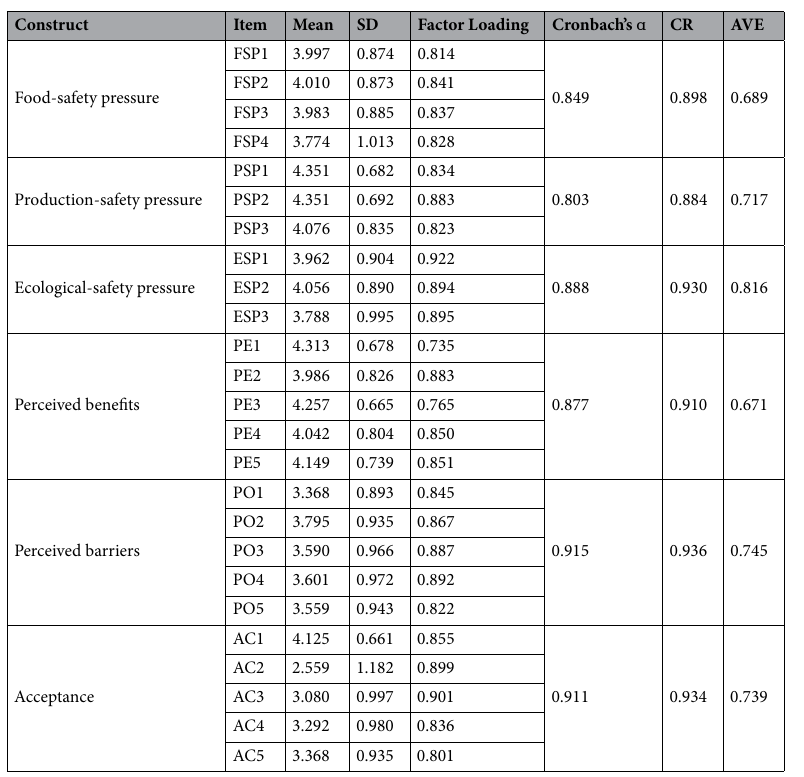
Table 3. Reliability, convergence validity, and collinearity testing (N = 288). Data sources: Calculation and arrangement of this paper.